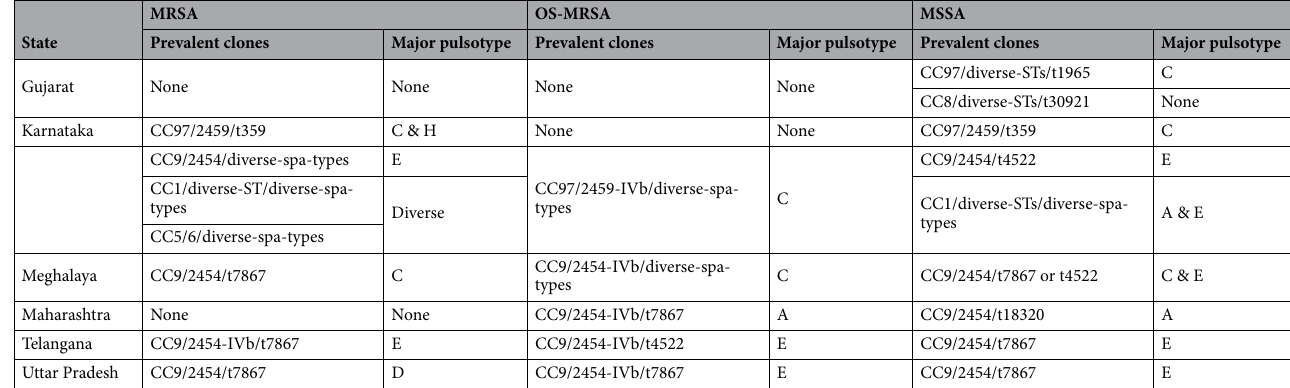
Table 2. Prevalence of different clones among MRSA, OS-MRSA and